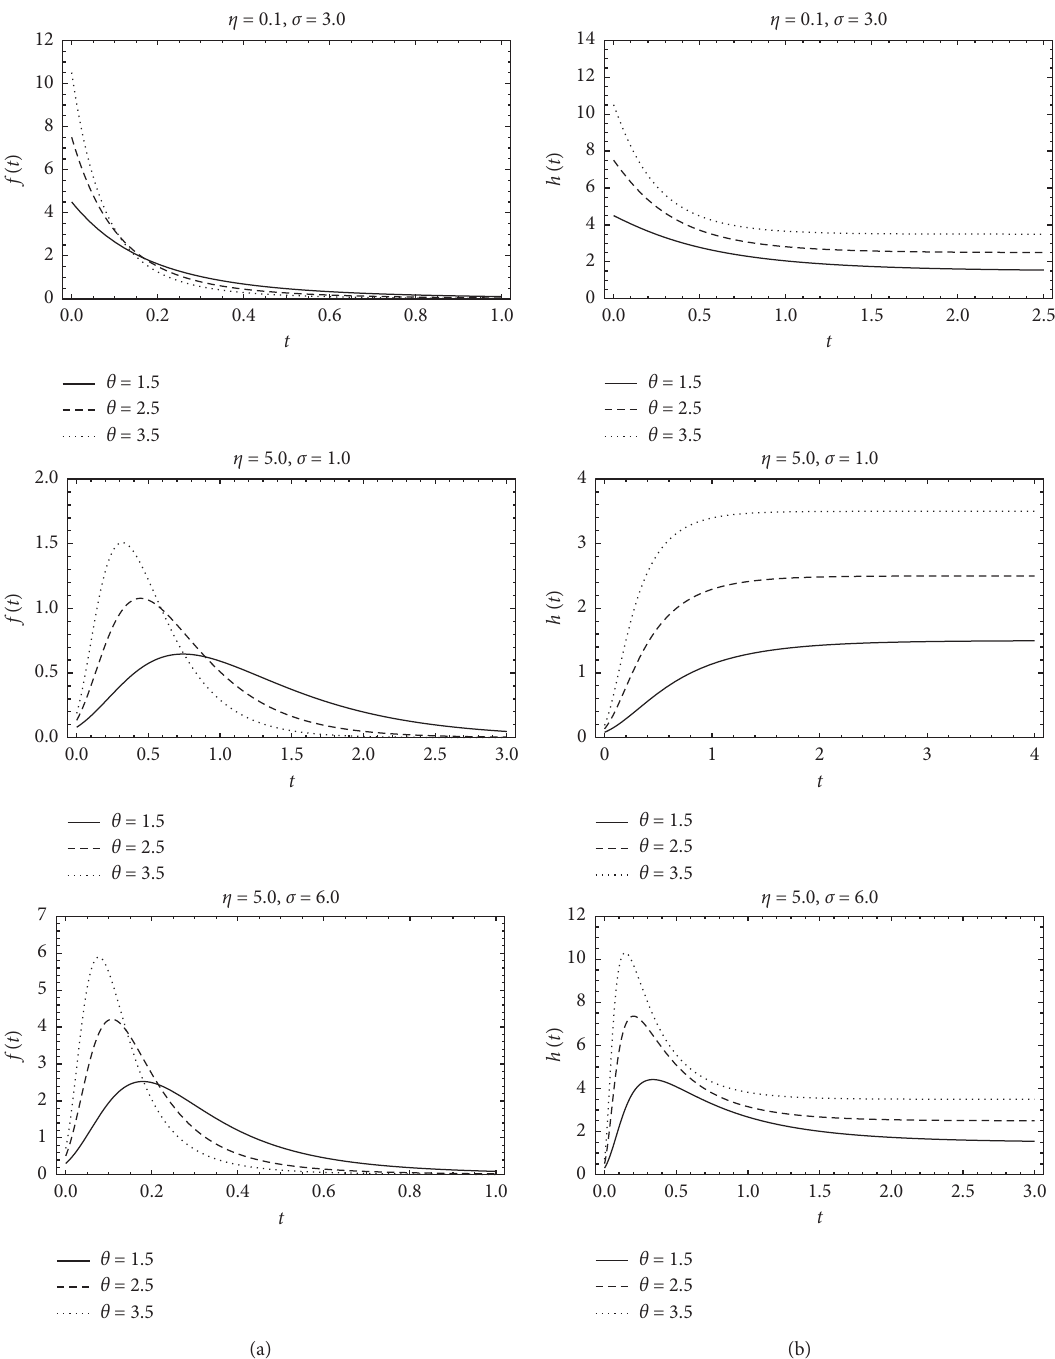
Figure 2: (a) The PDF and (b) HRF of the EDPD for different values of η , σ , and θ